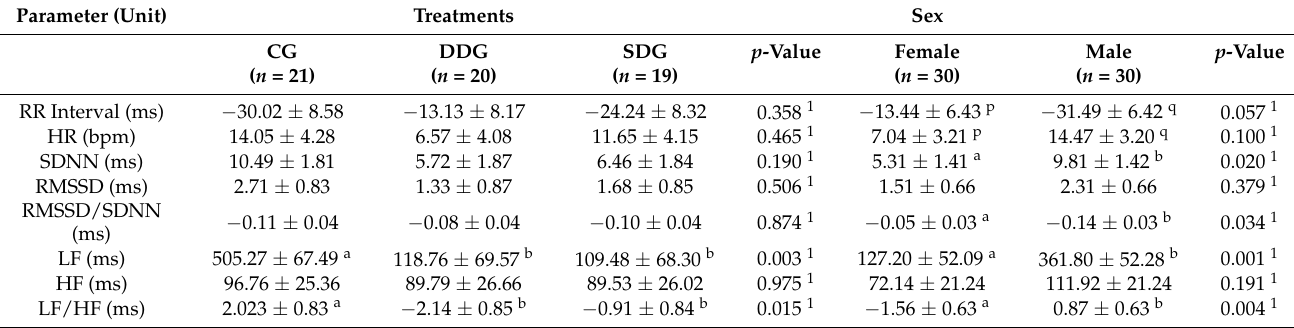
Values within a row with different letters significantly differ ( a , b : p < 0.05) or tend to differ ( p , q : 0.05 < p < 0.1). CG = control group; DDG = dominant demonstrator group; SDG = subordinate demonstrator group. RR Interval = intervals between adjacent heart beats; HR = heart rate; SDNN = standard deviation of the inter-beat intervals; RMSSD = the root mean square of subsequent inter-beat intervals; LF = low frequency band; HF = high frequency band. ms = millisecond; bpm = beats per minute. 1 mixed ANOVA model. Data are expressed as estimated marginal means and standard error means (E.M.M. ±